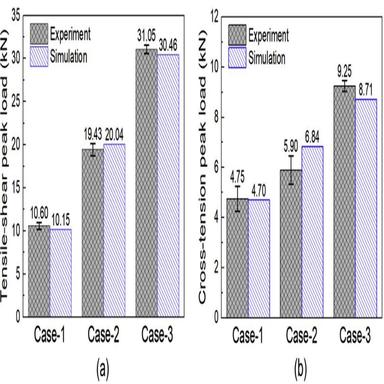
Peak load comparison between experiment and simulation. (a) Tensile-shear; (b) cross-tension.